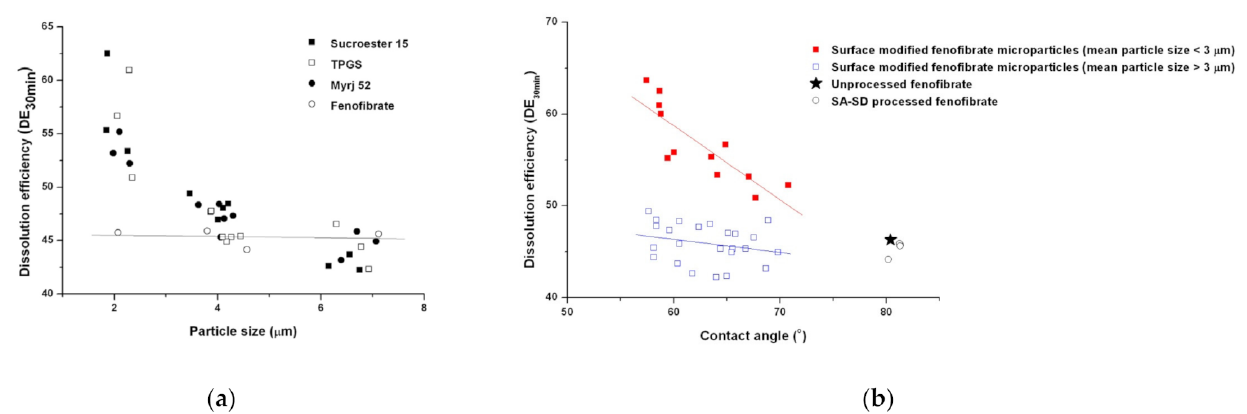
Figure 9. Scatter plots indicating the relationship of the dissolution efficiency versus ( a ) the mean particle size and ( b ) the